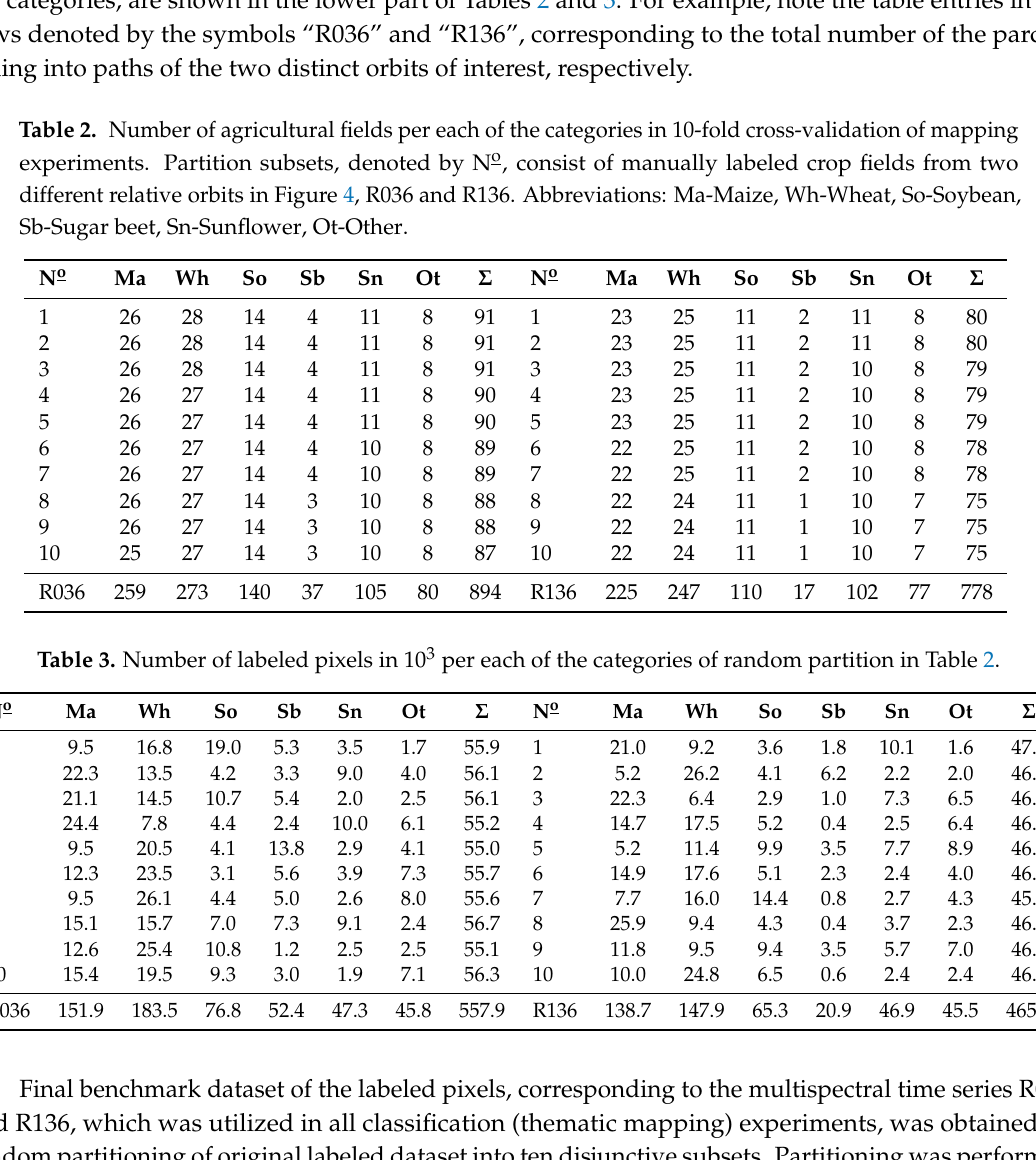
Final benchmark dataset of the labeled pixels, corresponding to the multispectral time series R036 and R136, which was utilized in all classification (thematic mapping) experiments, was obtained by random partitioning of original labeled dataset into ten disjunctive subsets. Partitioning was performed at the plot level in order to avoid that some pixels from the same field enter into another partition subset. Consequently, distribution of pixels corresponding to different crop types is not completely uniform over the 10 different, randomly generated subsets of the partition, Table 3. However, distribution of number of plots that are corresponding to different crop types over the 10 different subsets of the partition is approximately uniform, as illustrated by the entries in different rows of the Table